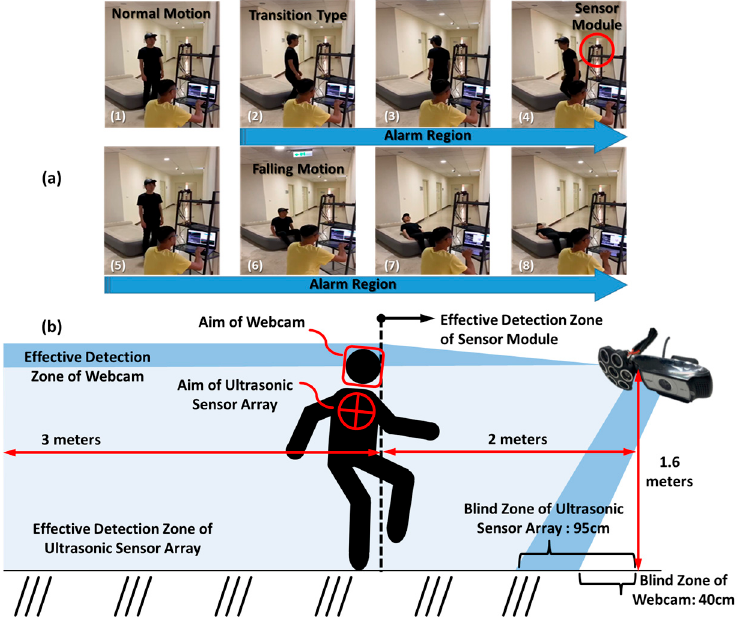
Figure 2. The series of images in ( a ) show the whole proposed experimental environment and falling stages. The sensing module was mounted on a shelf 1.6 m, and the data were collected and returned to the computer for model training. The alarm occurred when the hybridized platform sensed a transition. The image in ( b ) exhibits a detection-tracking scene of the proposed sensing scheme. Critical dimensions of effective and blind zones are clearly delineated. The targets of the ultrasonic sensor array and webcam were human chests and faces, respectively.